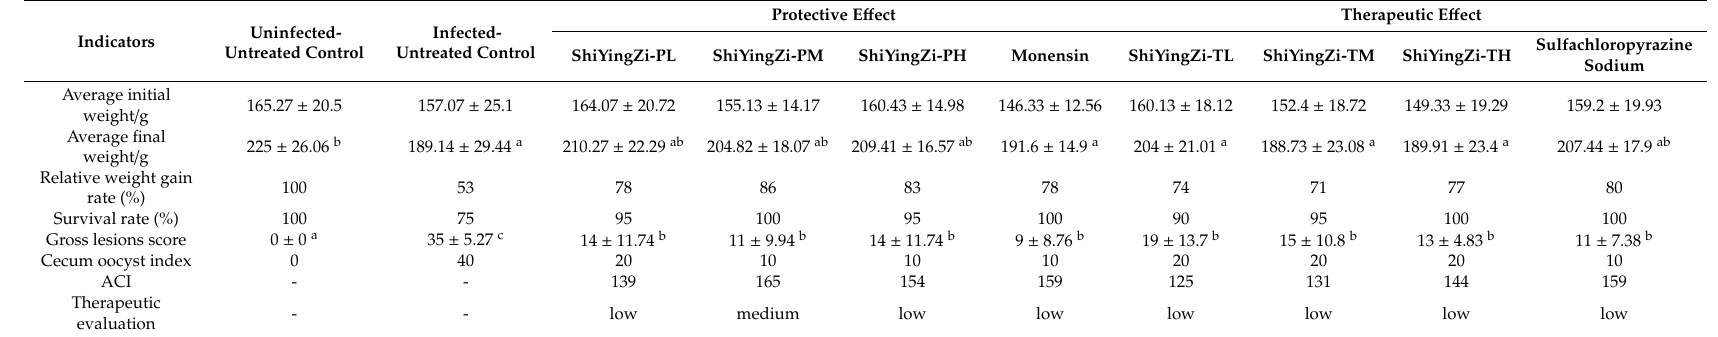
Table 4. Anti-coccidiosis